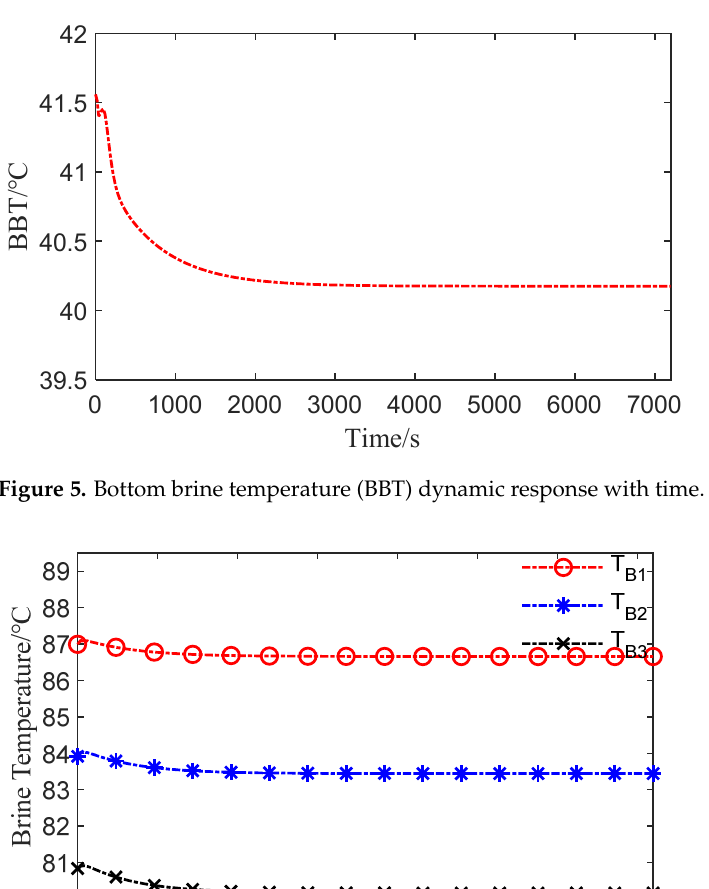
Figure 4. Top brine temperature ( TBT) dynamic response with time.